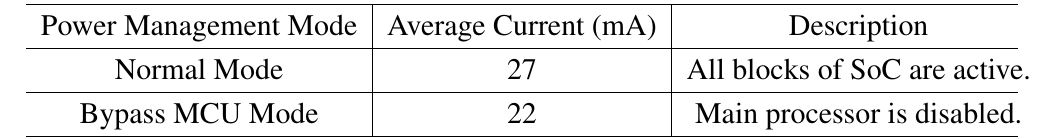
Table 1. Power consumption Comparison